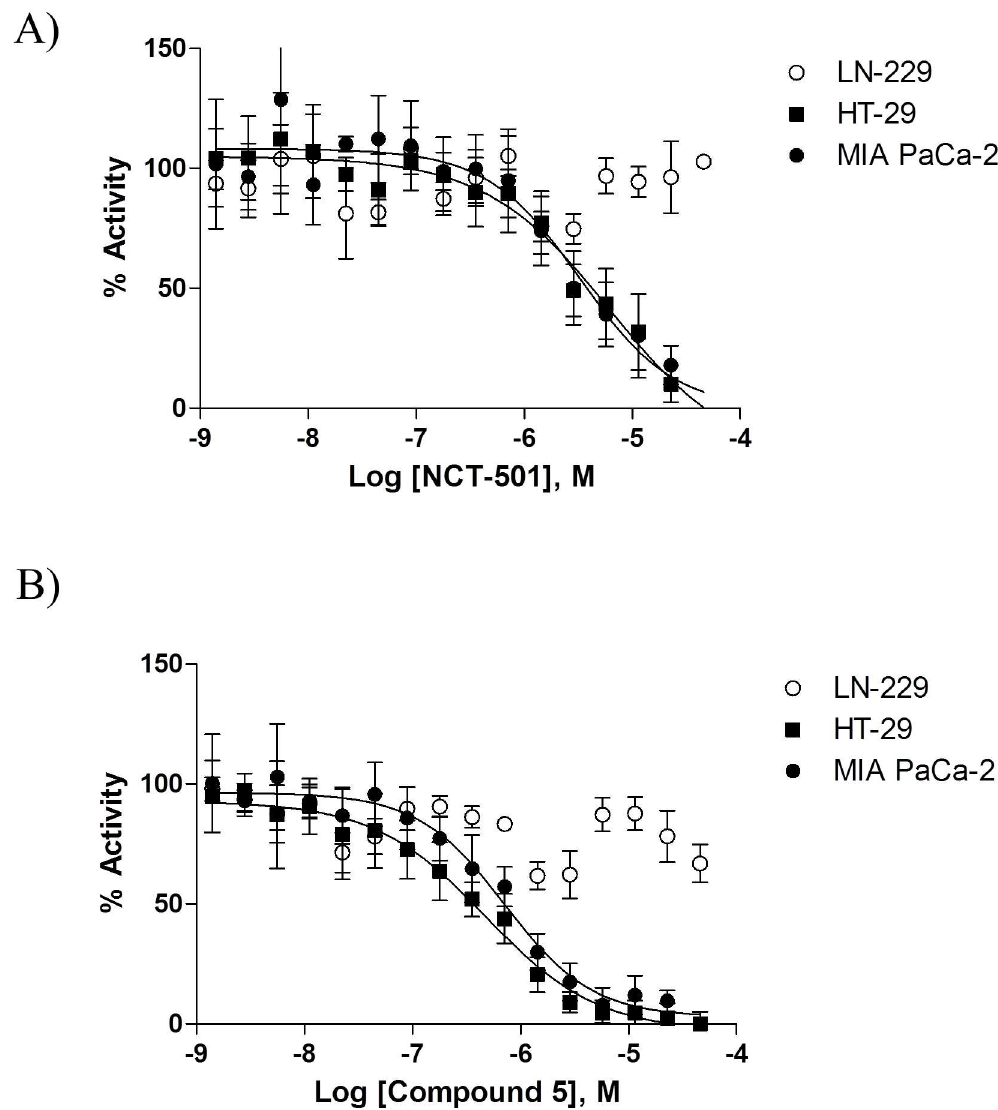
Fig 5. Differential ALDH-expressing patterns allow the detection of specific ALDH1A1 inhibitors. Dose responsecurves of ALDH1A1-specific inhibitorsNCT-501 (A) and Compound 5 (B) in MIA PaCa-2 and